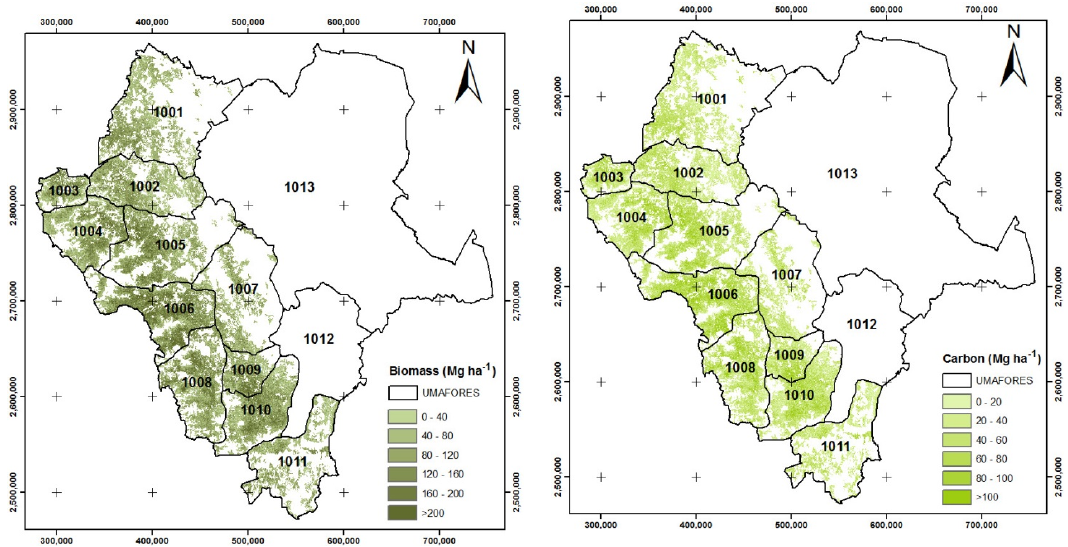
Figure 5. Spatial distribution of total above ‐ ground biomass (AGB) ( a ) and carbon content ( b ) in the Durango, Mexico forest study area estimated by the Support Vector Machine for Regression (SVM) approach.